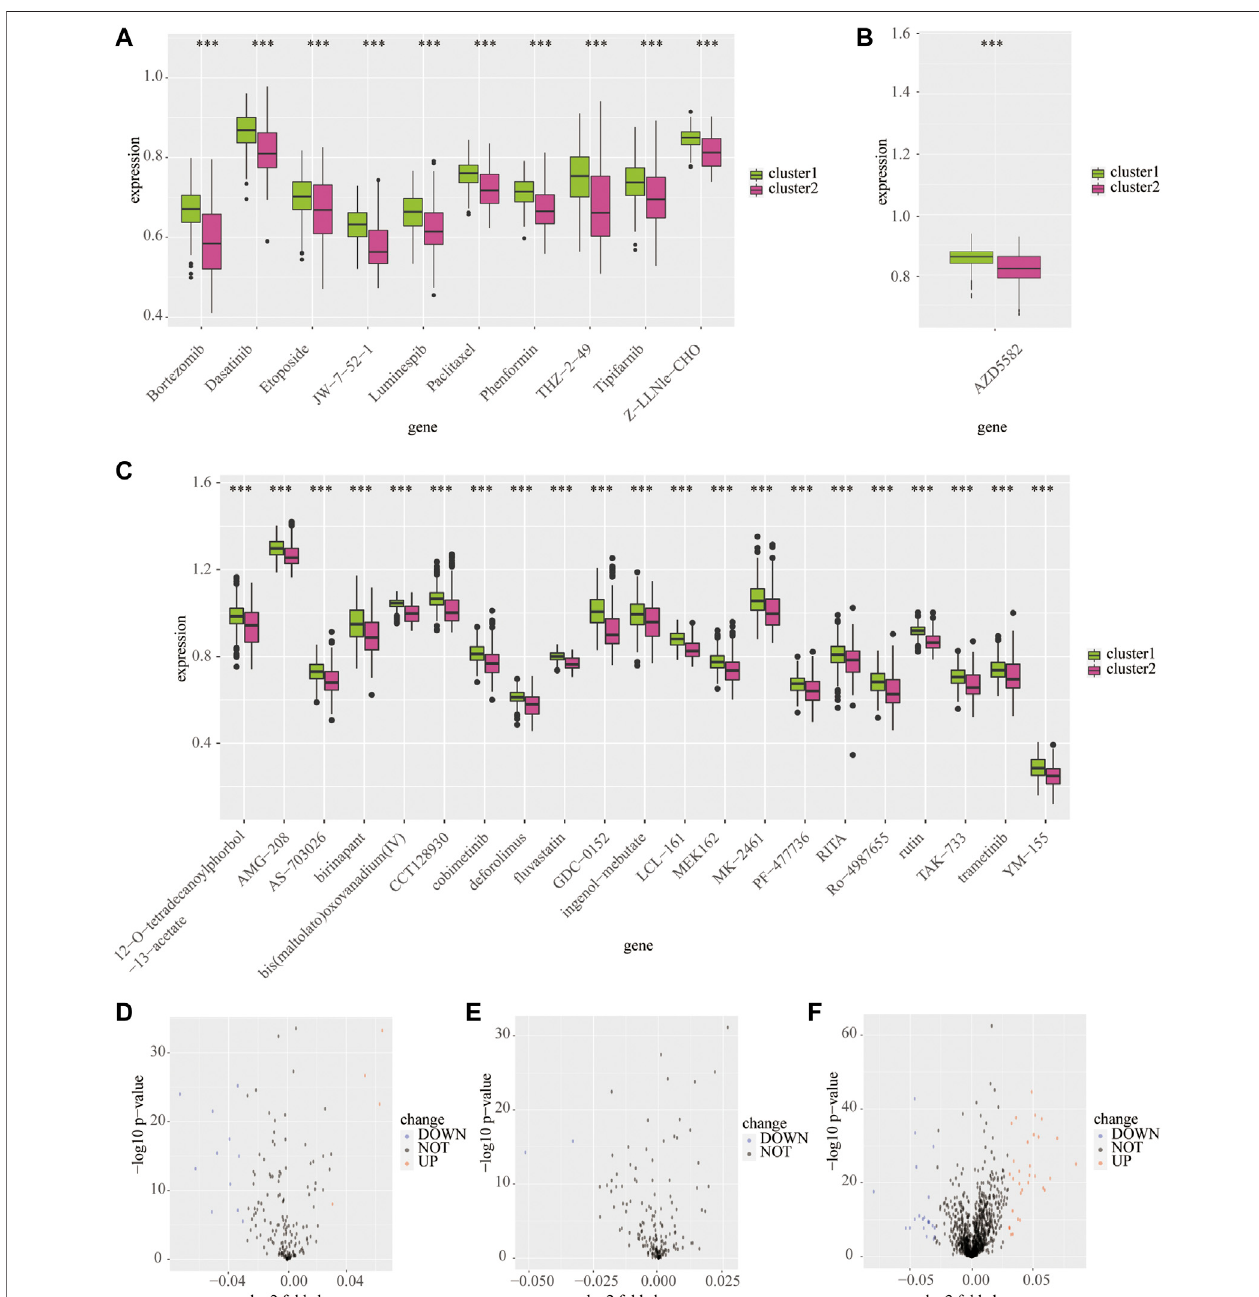
FIGURE 7 | Predicted potential sensitivity compounds based on the cluster model using public databases. The box plot shows sensitivity compounds between cluster1andcluster2basedontheCTRP1 (A) ,CTRP2 (B) ,andPRISM (C) databases.Thevolcanoplotsshowssensitivitycompoundsbetweencluster1andcluster2 based on the CTRP1 (D) , CTRP2 (E) , and PRISM (F) databases. *** p < 0.001.